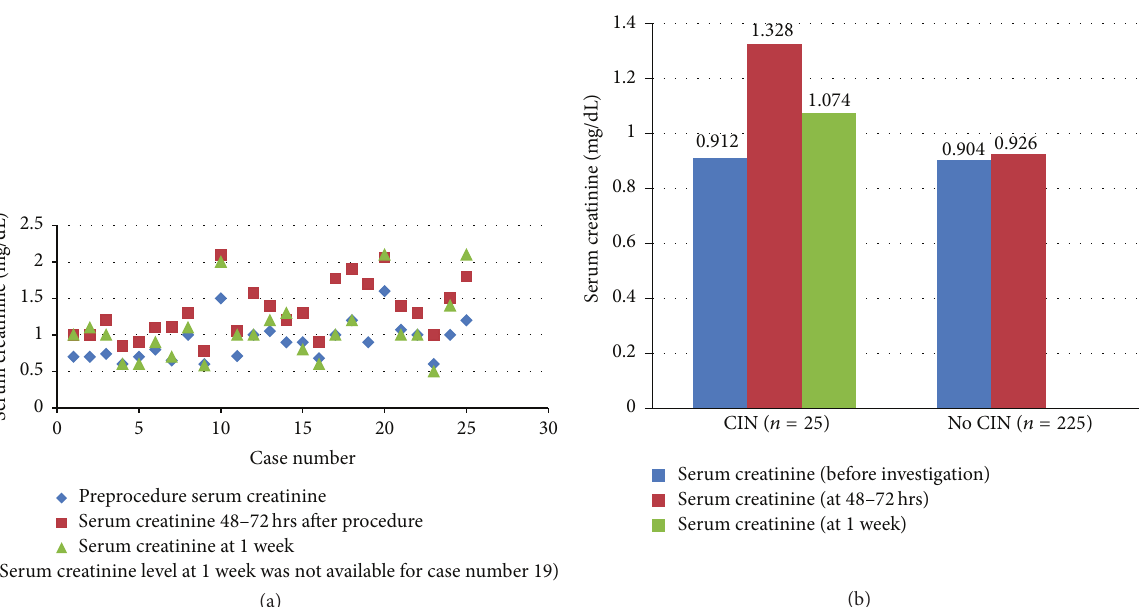
Figure 1: (a) Scatter diagram depicting serum creatinine levels at different time intervals in “CIN” patients. (b) represents the mean serum creatinine values in the pre- and post-IV iodinated contrast investigation in the CIN and the No CIN groups.